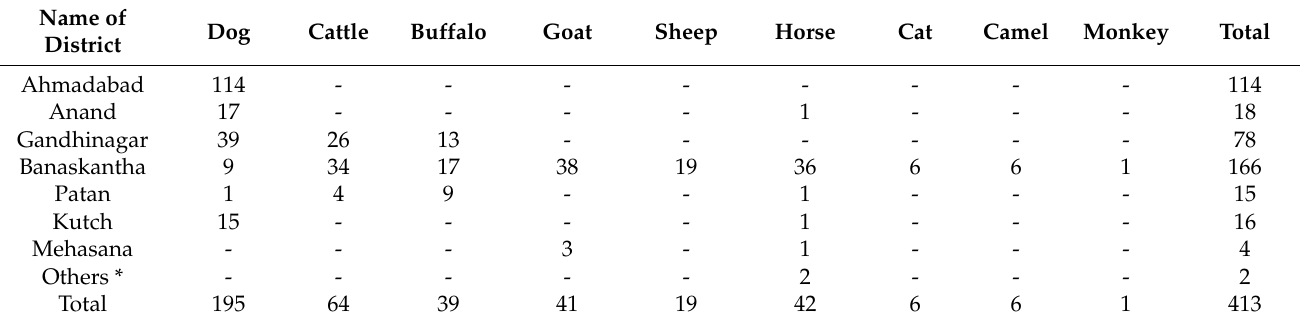
Figure 1. Map of Gujarat showing the locations of sample collections highlighted in yellow color. Table 1. Sampling details for COVID ‐ 19 surveillance in animals.